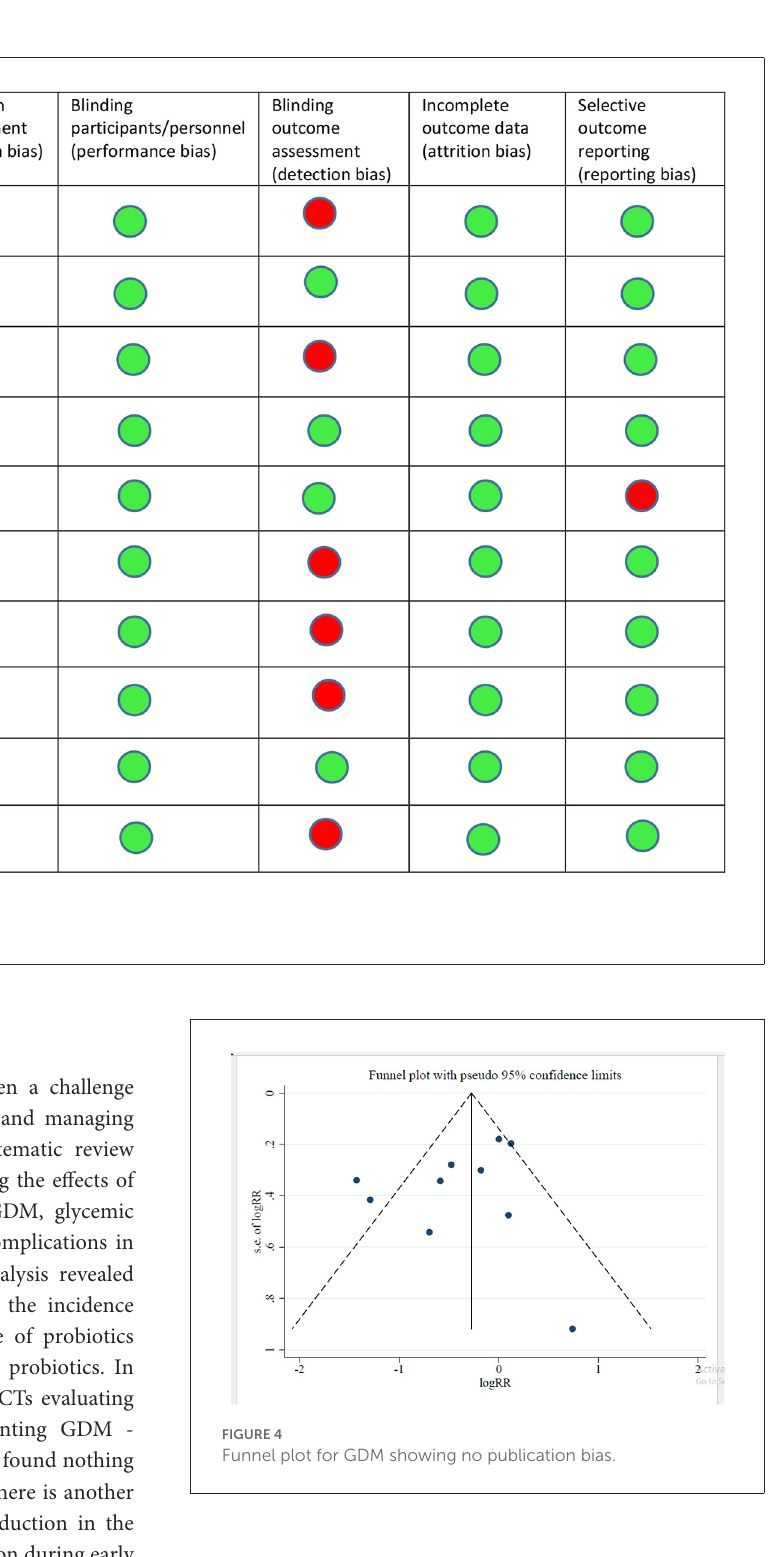
and past medical history of participants, various probiotics dosages and bacterial species, different modes of delivery, duration and frequency of probiotics